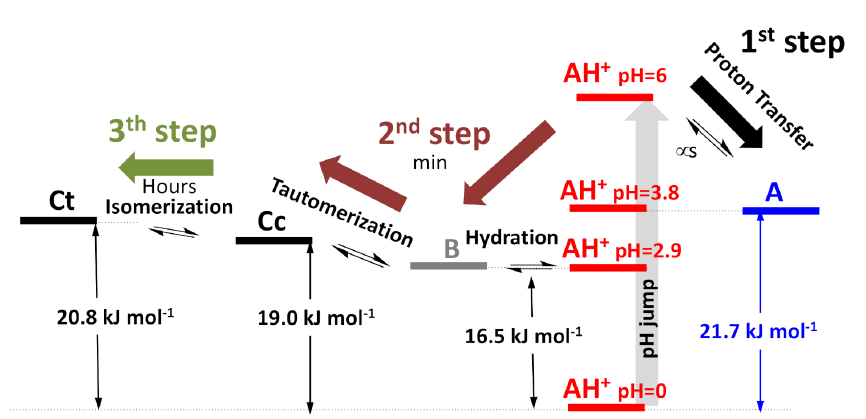
Figure 1. Energy level diagram for kuromanin in acidic medium. The sequence of reactions after a direct pH jump is